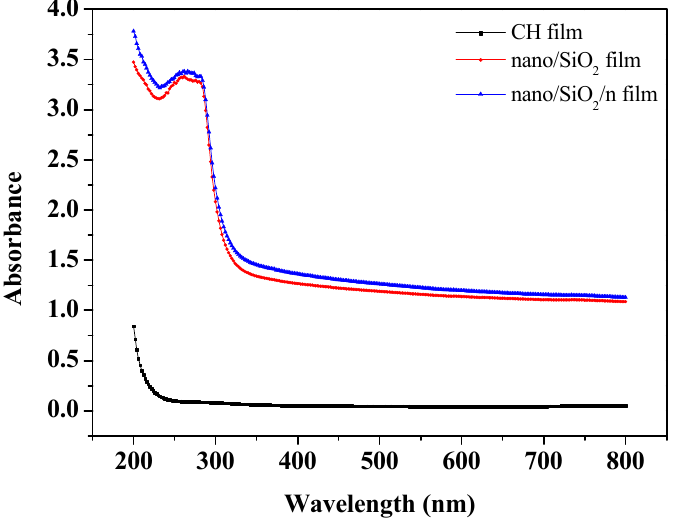
Figure 4. Optical absorption of thin novel films at 200–800 nm